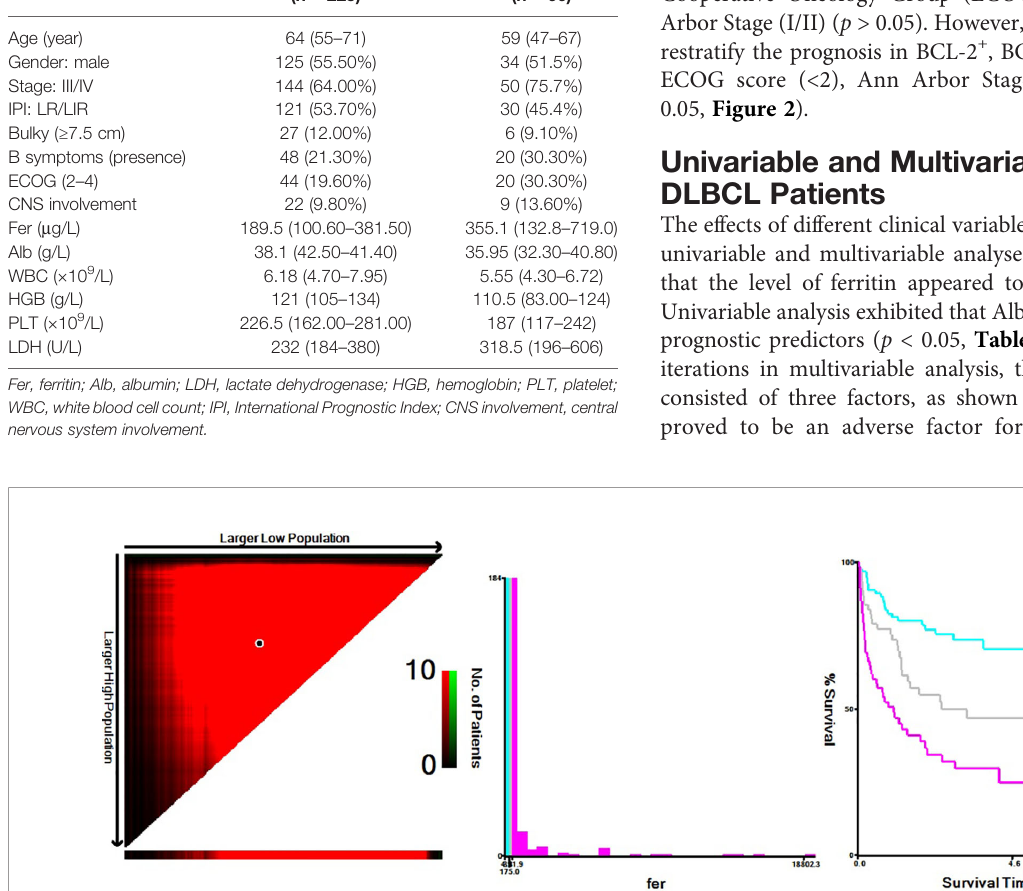
( Figure 2A ). Using cutoff values of 50% positive tumor cells for BCL-2 and BCL-6, 92 (31.60%) cases were positive for BCL-2, and 93 (31.90%) cases were positive for BCL-6. Thirty-six (12.4%) patients were with high Ki-67 score ( ≥ 0.9), and 81 (27.80%) were non-GCB. Kaplan – Meier analysis found that levels of ferritin could not re-stratify BCL-2, CD5, and Eastern Arbor Stage (I/II) ( p > 0.05). However, the levels of ferritin could